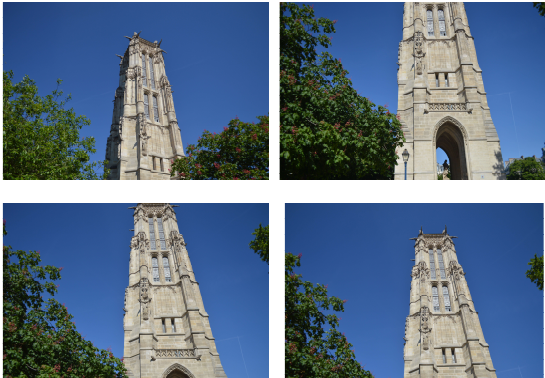
Figure 3 . A selection of the images contained in the dataset